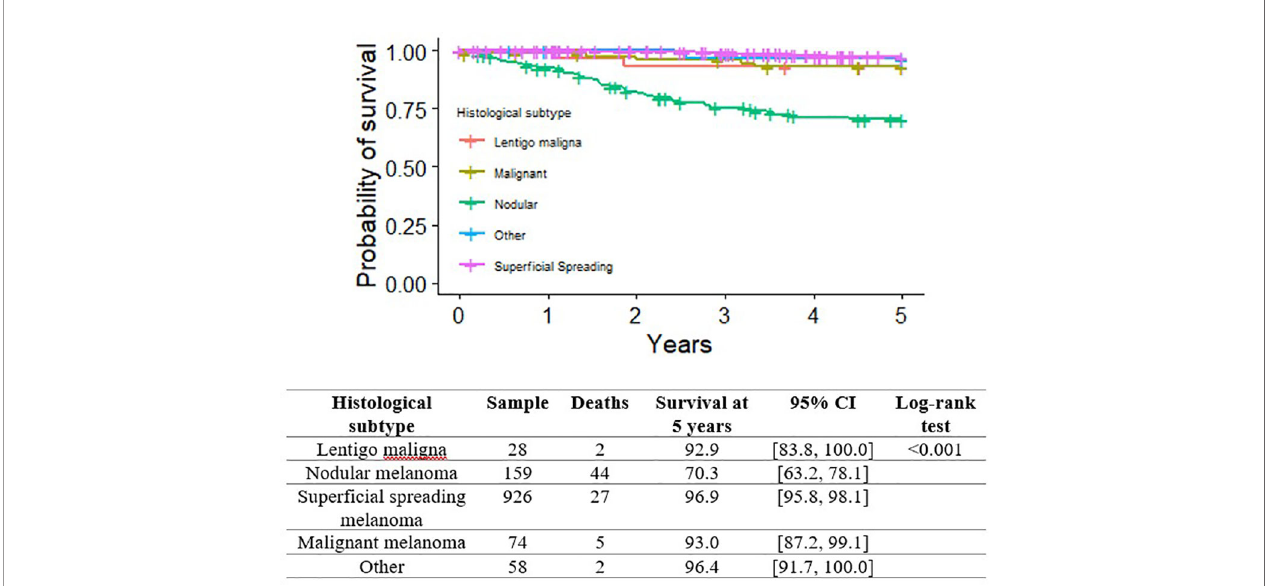
FIGURE 3 | Kaplan-Meier curves for melanoma-speci fi c survival by histological subtype and presence of mitoses.